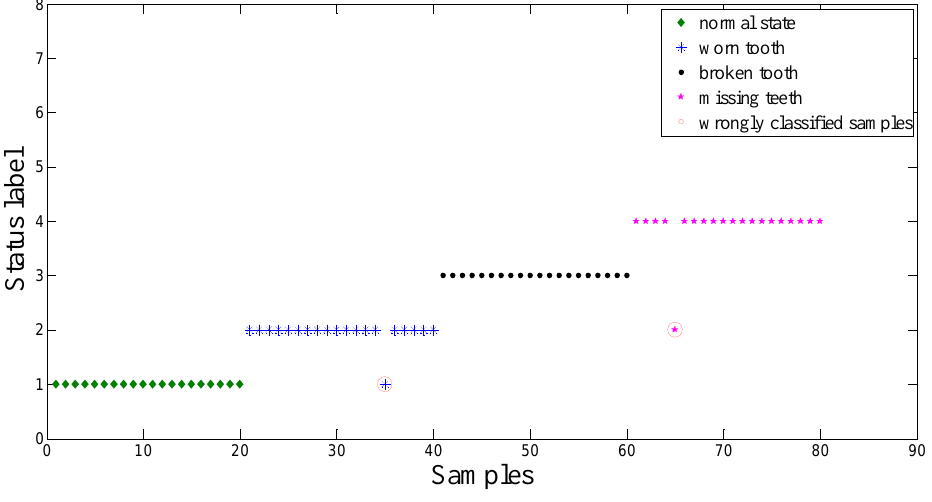
Figure 10. Classification result based on ACO-RVM classifier in the bevel gearbox